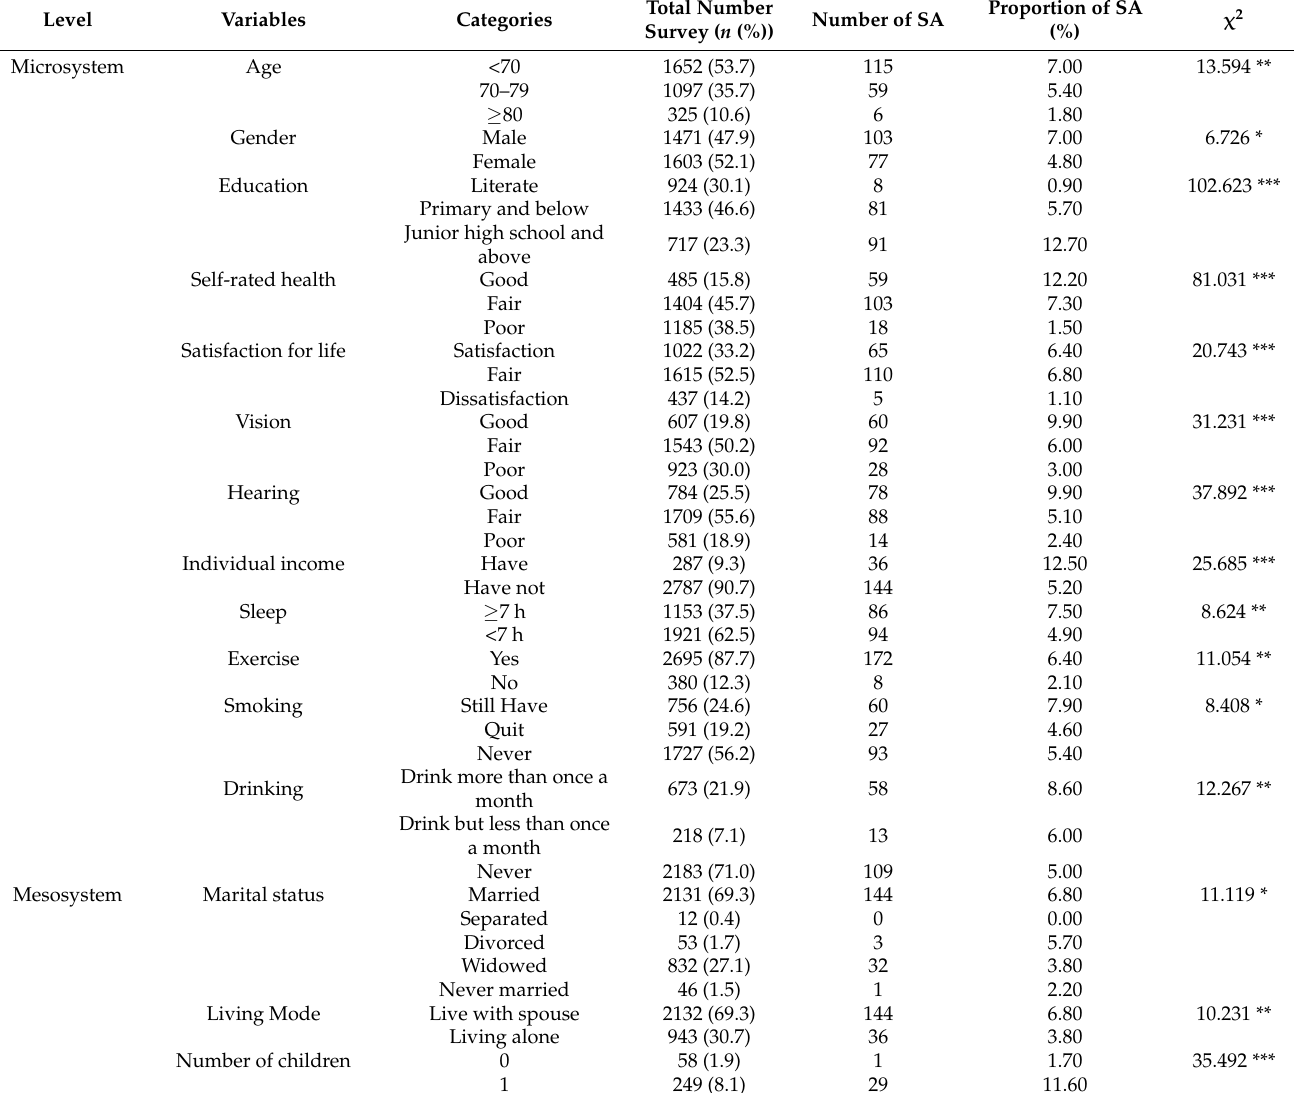
Table 1. Characteristics of participants and factors related to successful aging ( n =